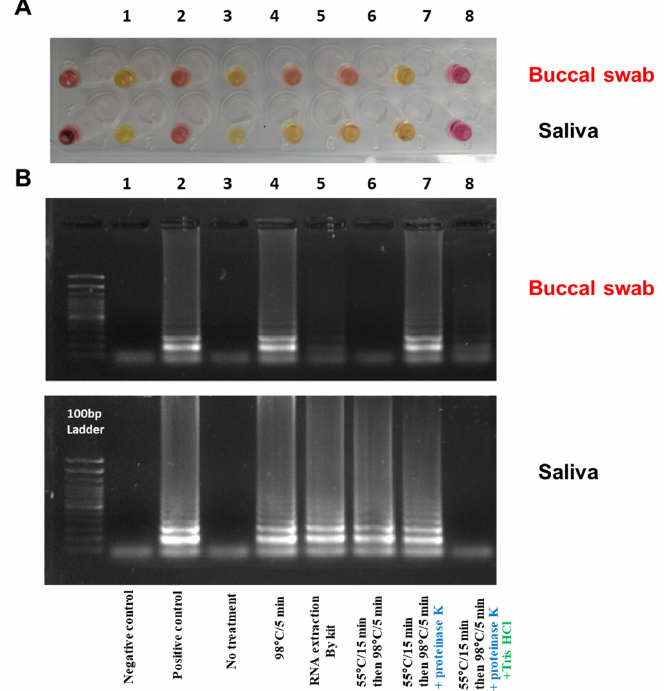
Figure 10. Optimizing RT-LAMP assay with different RNA extraction methods; ( A ) Using different extraction methods to show RT-LAMP on the RNAse P from the buccal swab and saliva sample; ( B ) Gel electrophoresis for the RT-LAMP assay resulted from A. Tube number ( 1 ) negative control (water), ( 2 ) positive control (RNA from COVID-19 patient), ( 3 ) sample without treatment, ( 4 ) RNA extraction by kit method (Monarch Total RNA miniprep Kit from NEB), ( 5 ) heat treatment for the sample at 98 °C for 5 min, ( 6 ) heat treatment for the sample at 55 °C for 15 min then 98 °C for 5 min, ( 7 ) heat treatment for the sample at 55 °C for 15 min then 98 °C for 5 min with proteinase K, ( 8 ) heat treatment for the sample at 55 °C for 15 min then 98 °C for 5 min with proteinase K in Tris HCl buffer. The reaction was incubated in a heat block at 65 °C for 30 min. The pink color indicated a negative reaction, while the yellow indicated a positive one. The minimum time required for the RNA release with proteinase K and heat was furtherly assessed. A low temperature of 55 °C for 5 min with proteinase K yielded a negative reaction (i.e., pink color) for the buccal swab and a positive reaction (i.e., yellow color) for the saliva sample (Figure 11A1,B1). By testing different time and temperature points with the presence of proteinase K, it was observed that heating the samples (saliva and buccal swab) for 5 min at 98 °C resulted in a positive reaction for both samples (Figure 11A2,B2). Similarly, by heating the samples in two successive conditions; at 55 °C for 5 min, then 98 °C for 5 min (Figure 11A3,B3)), 55 °C for 10 min, then 98 °C for 5 min (Figure 11A4,B4), and 55 °C for 15 min 98 °C for 5 min (Figure 11A5,B5) all produced positive reactions. In addition, the potential of directly using proteinase K for RT-LAMP reaction with different volumes, i.e., 1, 3, and 5 μ L, was also evaluated as shown in Figure 11A6,